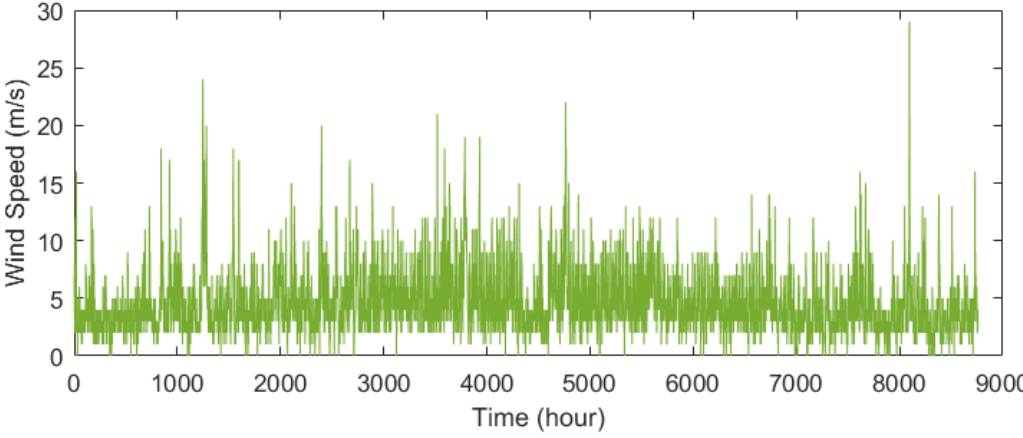
Figure 16. Profile of annual wind speed.